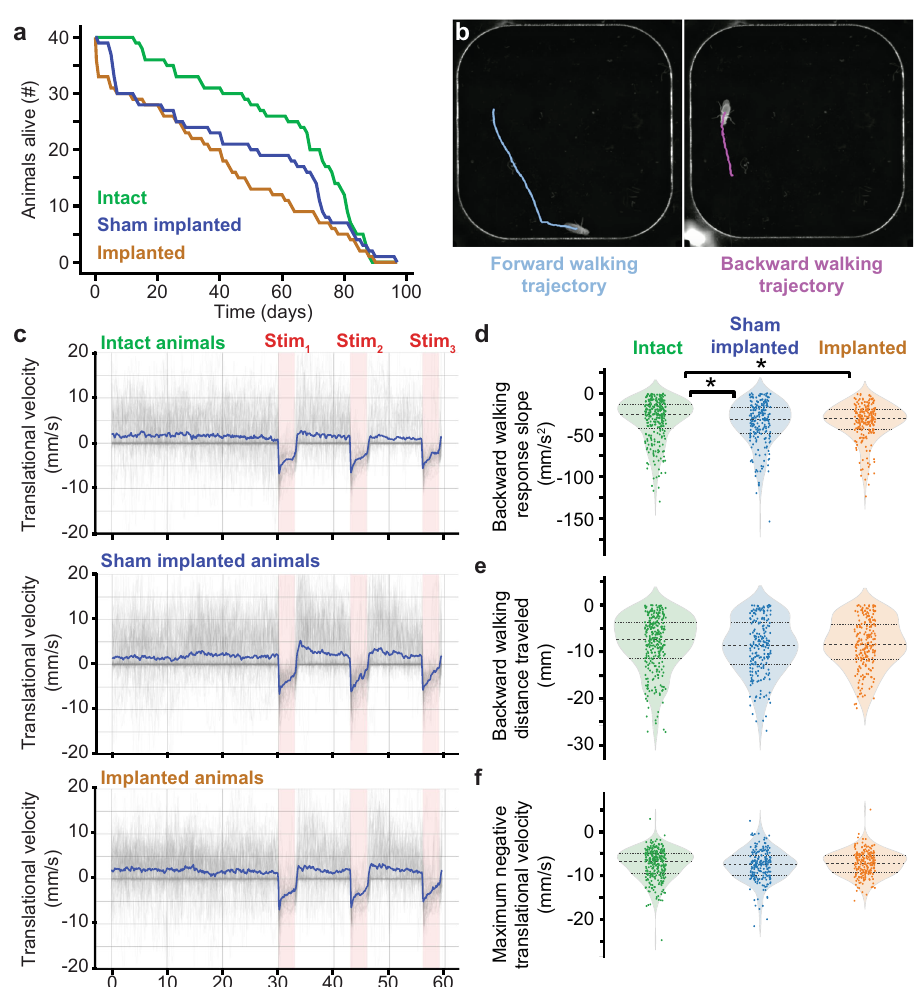
Fig. 2 | Impact of long-term imaging technologies on lifespan and behavior. a Survival curves for genetically-identical sibling animals that were (i) not experi- mentally manipulated (green, `Intact'), (ii) tethered, cold anaesthetized, and had their wings removed (blue, `Sham implanted'), or (iii) prepared for long-term imaging by implantation and the addition of a thoracic window (orange, `Implan- ted').SourcedataareprovidedasaSourceData fi le. b Behaviorswerecomparedby analyzing the dynamics of optogenetically activated backward walking within a rounded square-shaped arena. Locomotion was computationally analyzed and plotted, showing the animal's initial forward trajectory (cyan) and subsequent optically evoked backward walkingtrajectory(purple). c Translationalvelocitiesof intact(top),shamimplanted(middle),andimplanted(bottom)animalsduring30s